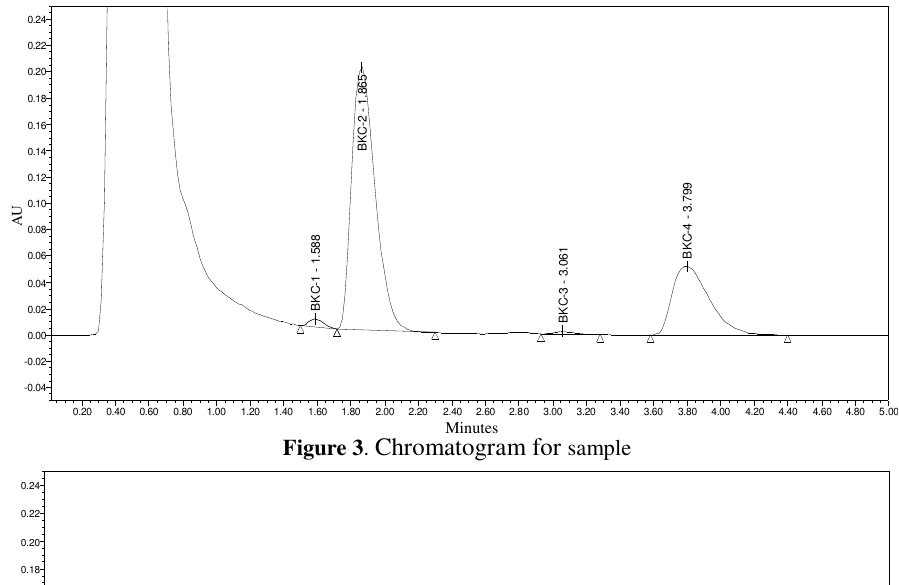
Figure 3 . Chromatogram for sample